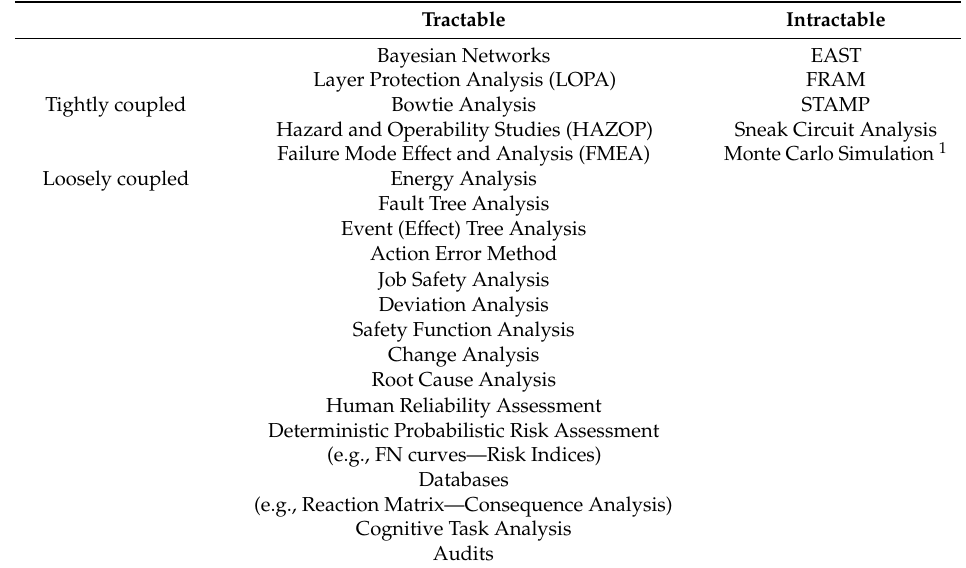
Table 3. Coupling and Tractability of the safety analysis methods